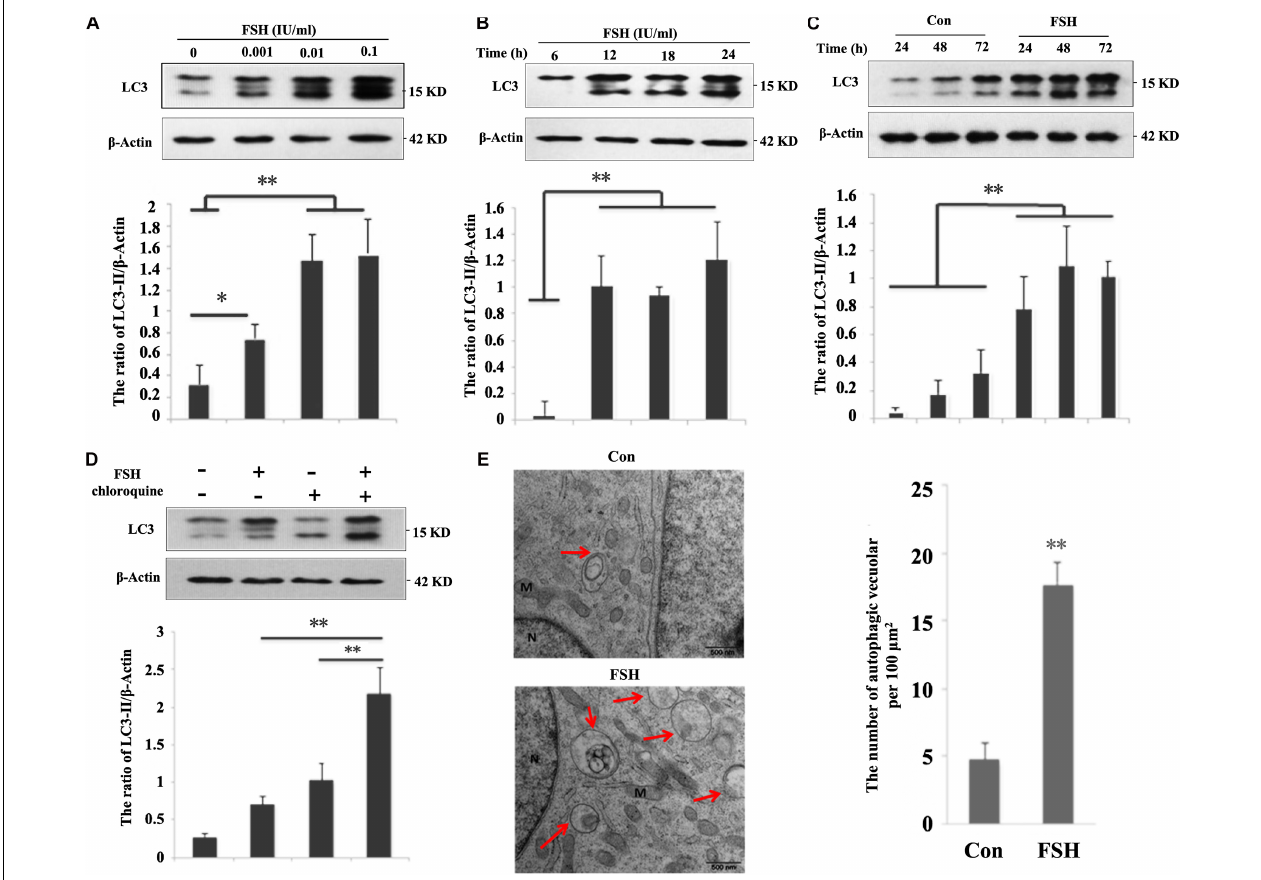
FIGURE 1 | FSH increases autophagy in porcine follicular granulosa cells. (A) Porcine follicles were cultured in the DMEM/F12 medium containing 0, 0.001, 0.01, and 0.1 IU/mL FSH for 24 h, LC3-II levels were detected in their lysates. (B) Porcine follicles were cultured in DMEM/F12 medium containing 0.01 IU/mL FSH for the indicated time, and LC3-II levels were detected in their lysates. (C) Porcine follicles were cultured with 0.01 IU/mL FSH for 24, 48, and 72 h, and LC3-II levels were assessed by immunoblotting their lysates. (D) Porcine follicles were cultured in DMEM/F12 medium containing 0.01 IU/mL FSH for 18 h and then chloroquine (10 µ M) was added for a further 6 h. LC3-II levels were detected by western blotting. ∗∗ , P < 0.01, and ∗ , P < 0.05 compared to the control group. The value shows the ratio of LC3-II to β -actin and normalized to that of the control. (E) Electron microscopic images of autophagic vacuoles in porcine GCs of cultured follicles after treatment with 0.01 IU/mL FSH for 24 h. Autophagosomes are seen (marked by arrows) as rounded vacuolar structures with multiple membranes containing cytoplasmic contents (bars, 500 nm). N: nuclear; M: